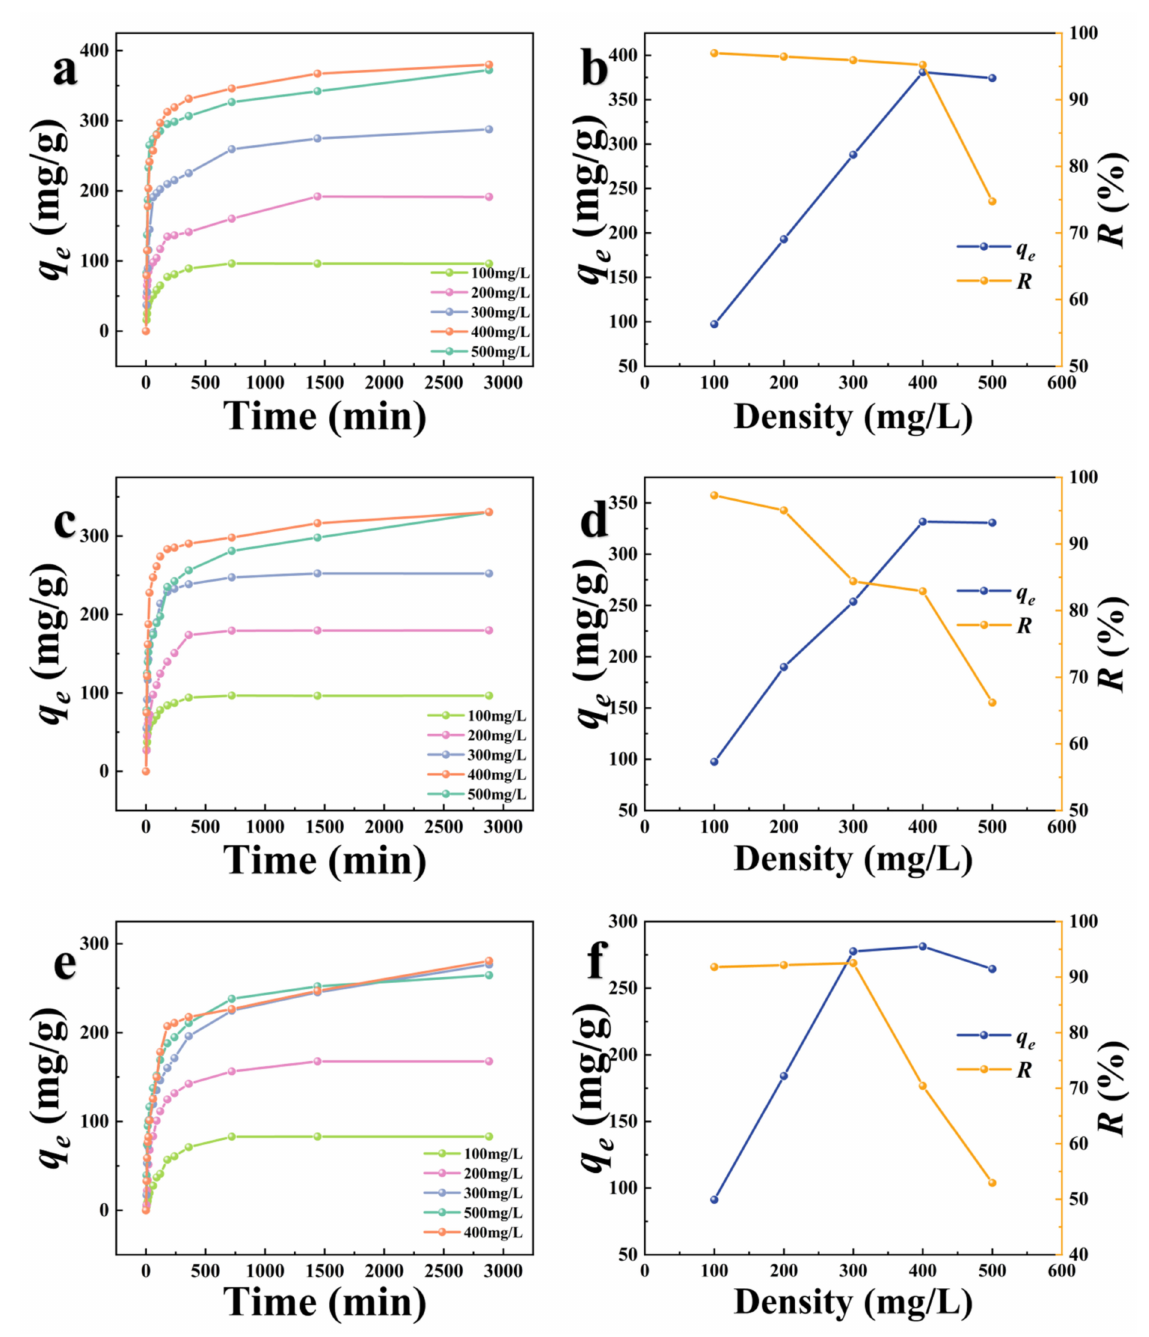
Figure 5. Adsorption of TC with different initial concentrations by modified carbon shell biochars at different times (( a , b ) are K − CSB; ( c , d ) are P − CSB; and ( e , f ) are M −